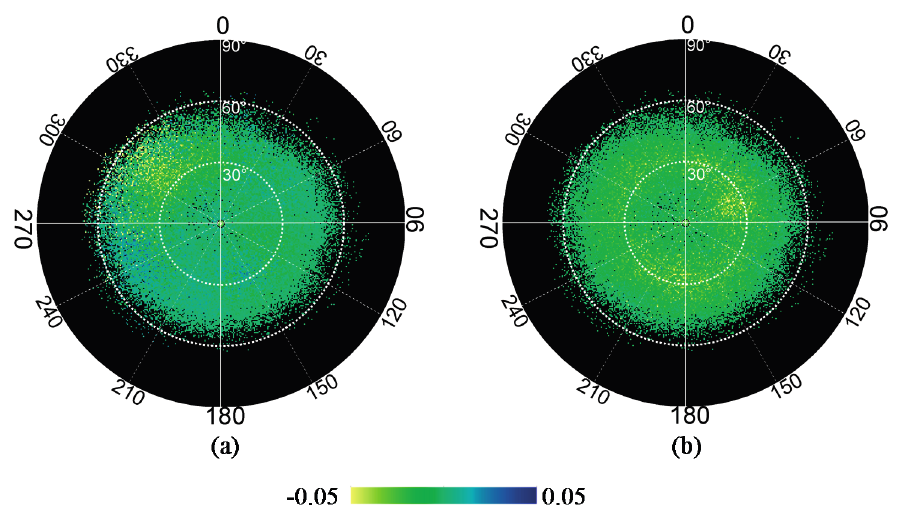
Figure 4. Reflectance intensity differences of band 4 between results from model proposed and Li model, ( a ) for the spring scene, and ( b ) for the autumn